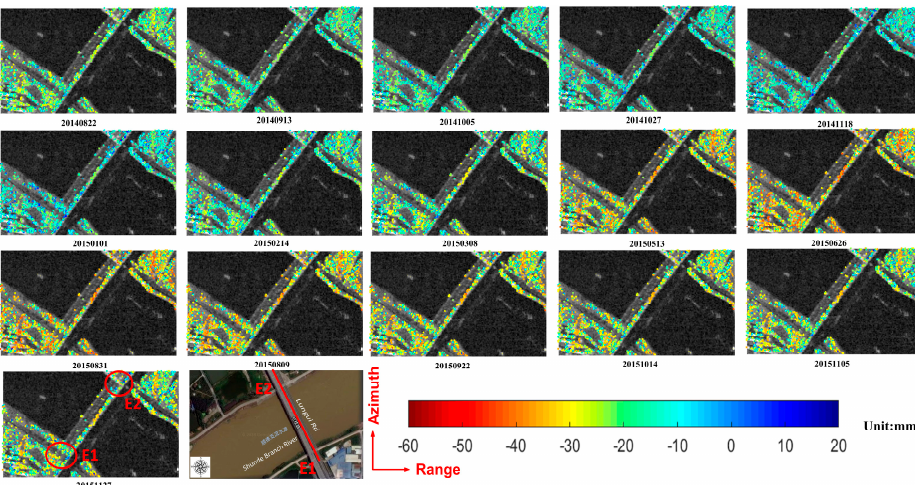
Figure 18. Time series of deformation over Anlite Bridge (referenced to 2014/06/17).